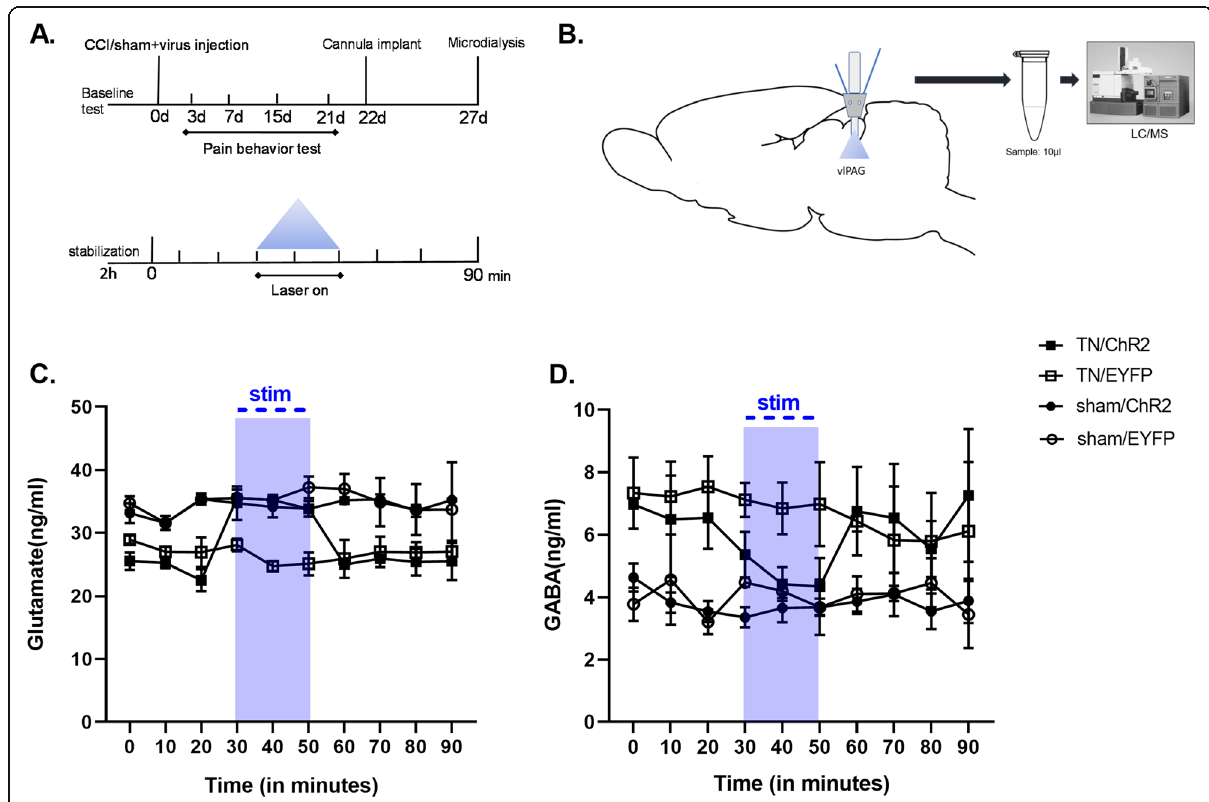
Fig. 5 Microdialysis analysis at vlPAG. a Experimental timeline demonstrating virus injection and cannula implantation (above) followed by collection of samples by microdialysis (below). b Schematic diagram showing microdialysis probe implanted and stimulation area followed by liquid chromatography- mass spectrometry (LC/MS) analysis. Extracellular glutamate ( c ) and GABA ( d ) concentration at vlPAG in different animal groups at different laser conditions within the 90 min period. Blue shaded area indicates the optic stimulation period at vlPAG